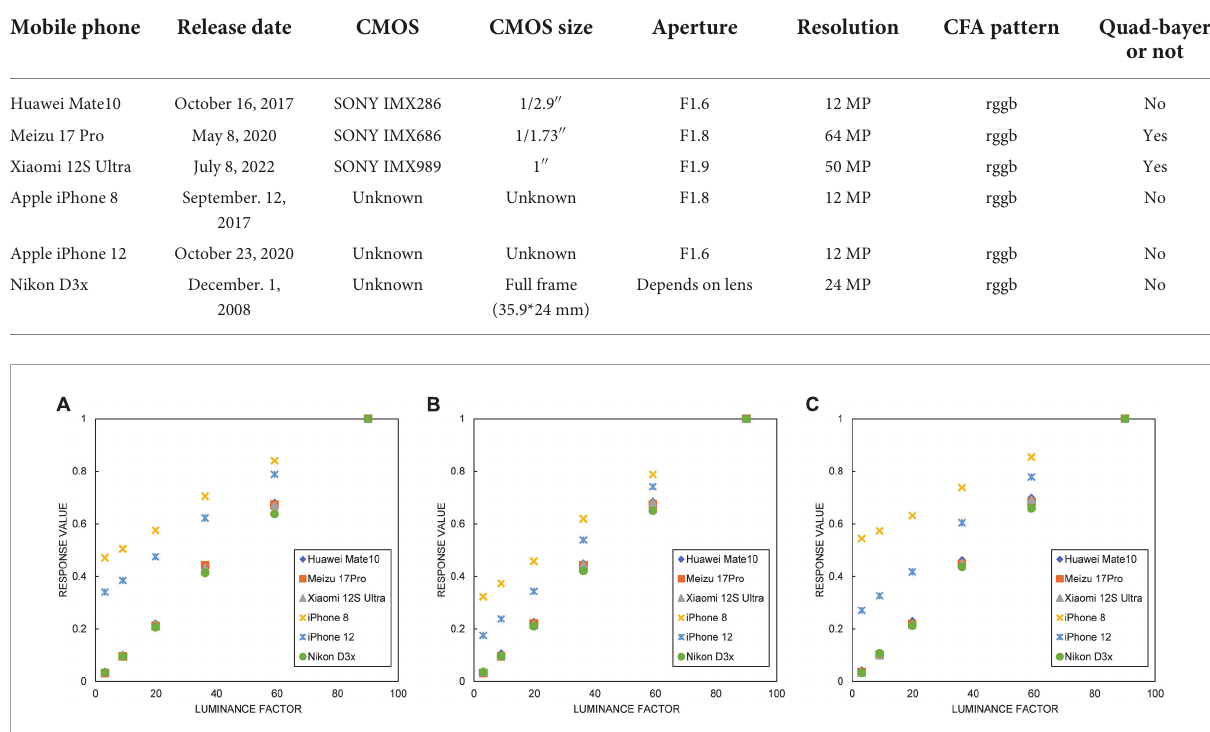
FIGURE5 Linearity of the three channels of raw response for six imaging devices: (A) R channel, (B) G channel, and (C) B channel.